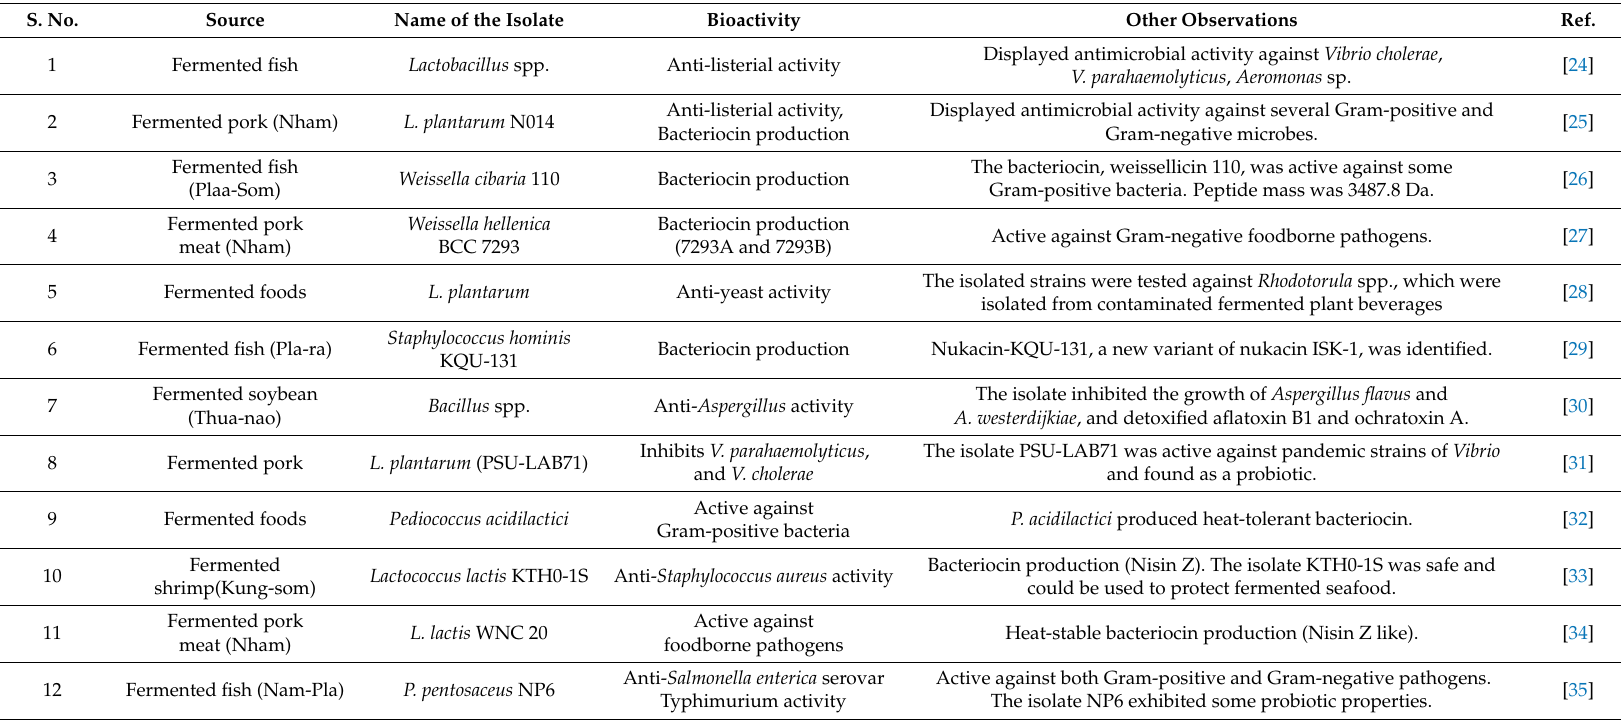
Table 1. Antimicrobial activities of lactic-acid bacteria isolated from Thai fermented